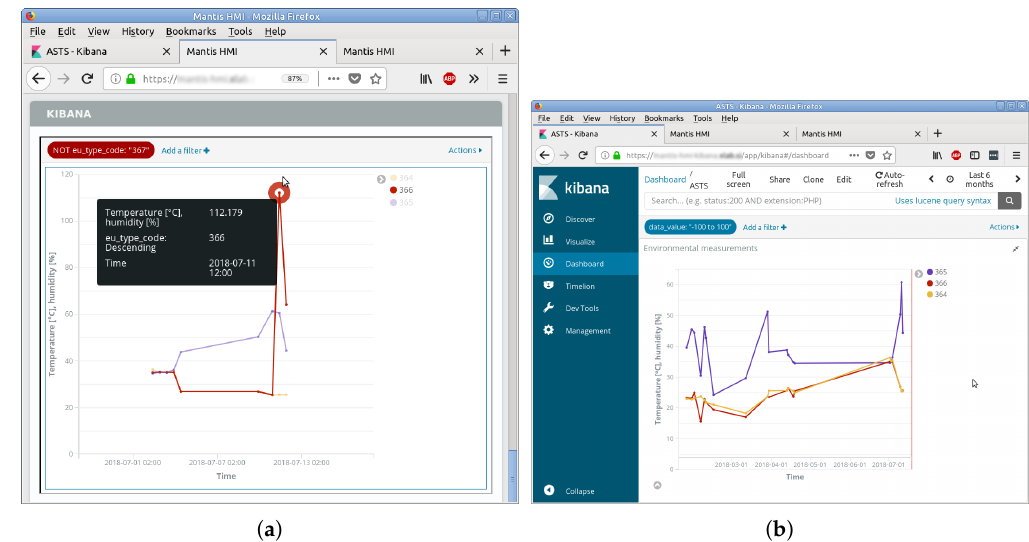
Figure 14. Kibana visualizations: ( a ) Graph of environmental parameters and ( b ) filtered sensor measurements.